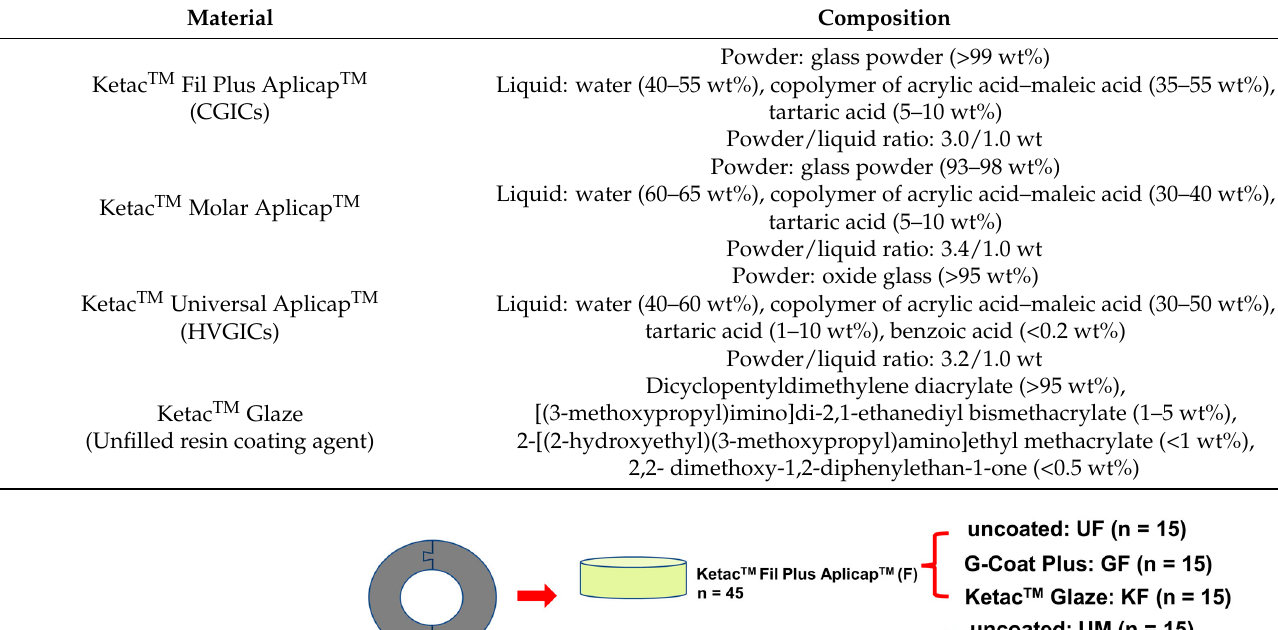
Table 1. Composition of the materials that were used in this study.